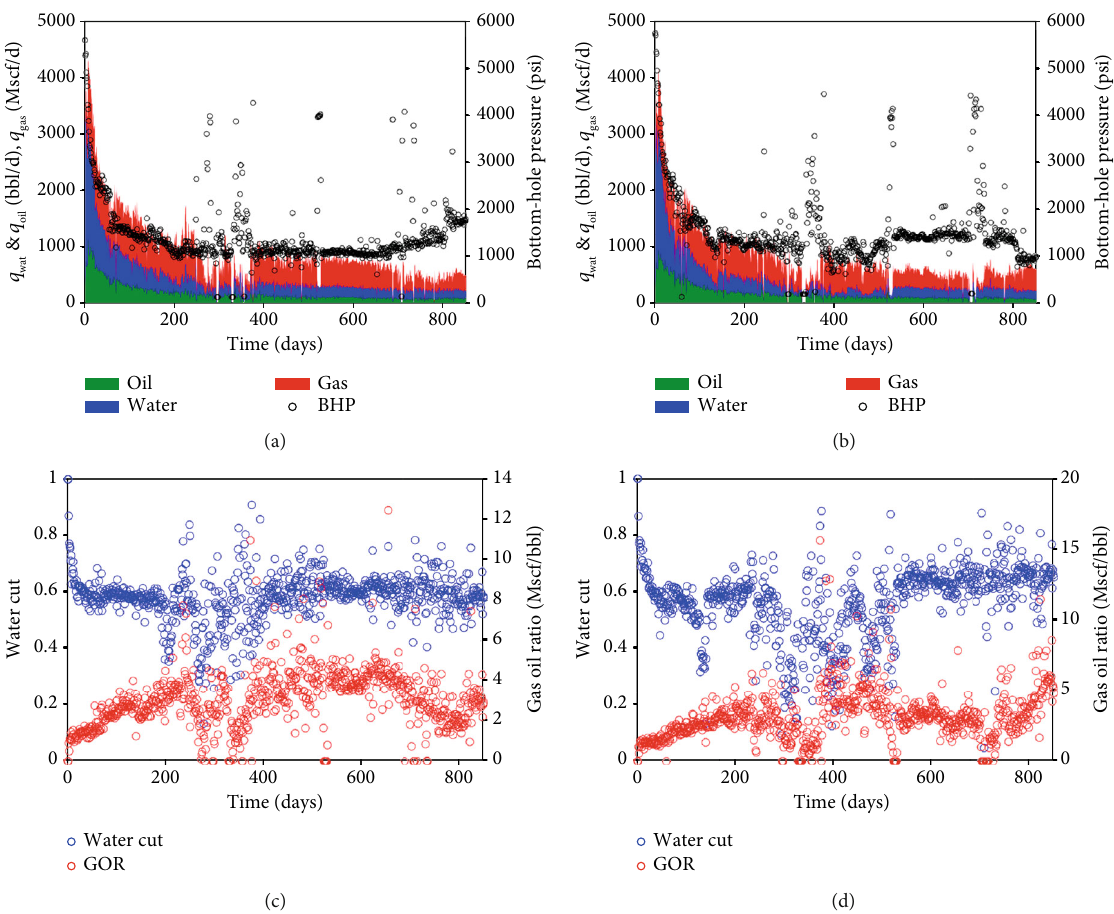
Figure 1: History data for well A and well B: (a) production rates and bottom-hole pressure for well A, (b) production rates and bottom-hole pressure for well B, (c) water cut and gas oil ratio for well A, and (d) water cut and gas oil ratio for well